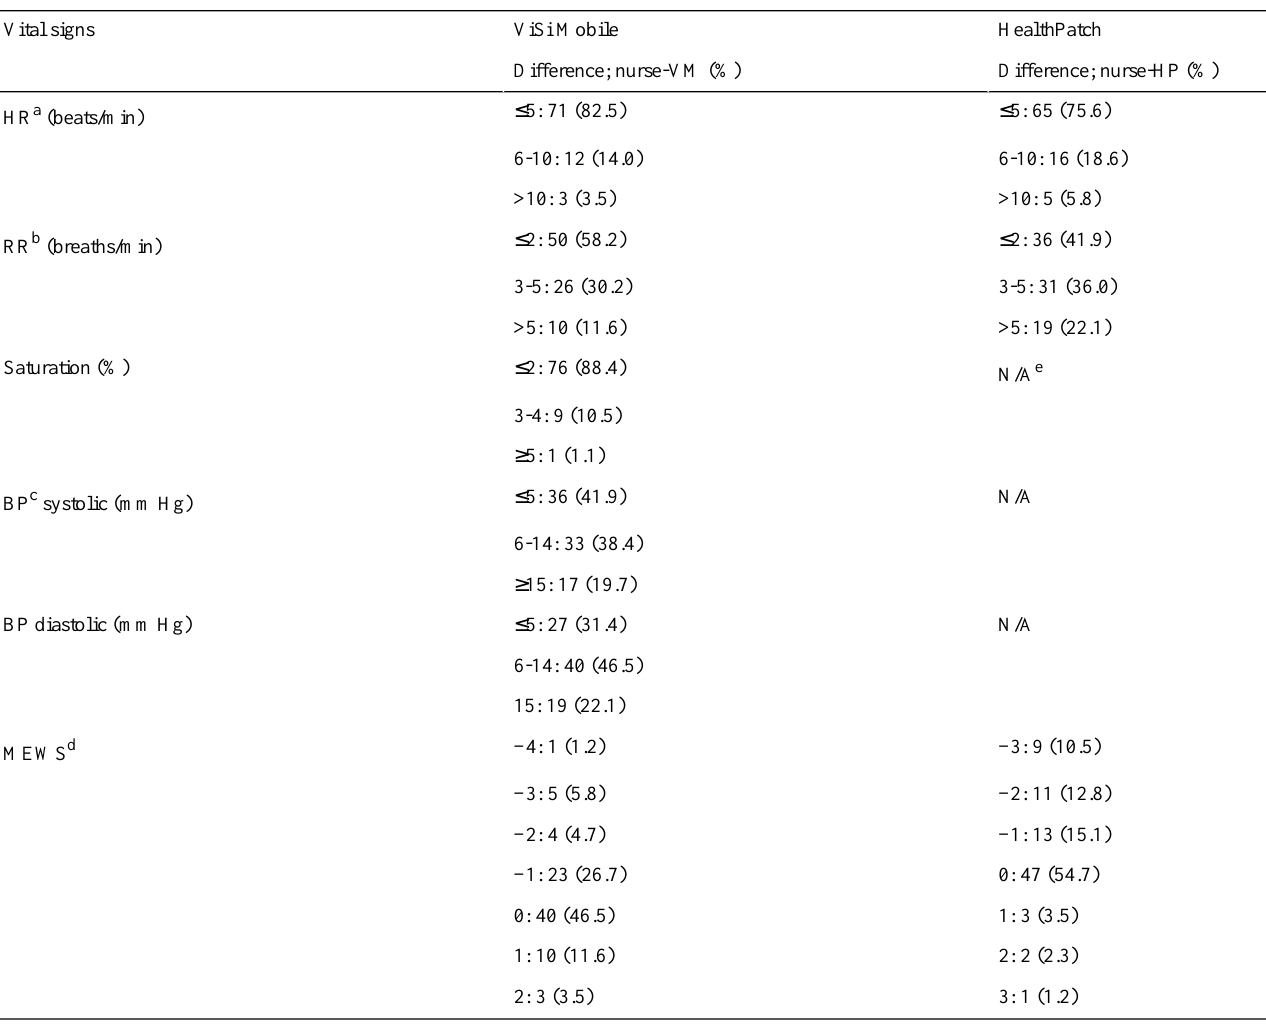
Table 3. ViSi Mobile (VM) and HealthPatch (HP) data in comparison with corresponding nurse measurements.